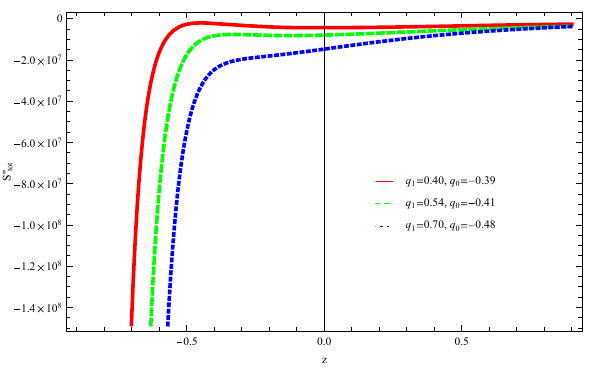
Fig. 4 Plot of S (cid:5)(cid:5) tot versus z at Hubble horizon with Bekenstein entropy